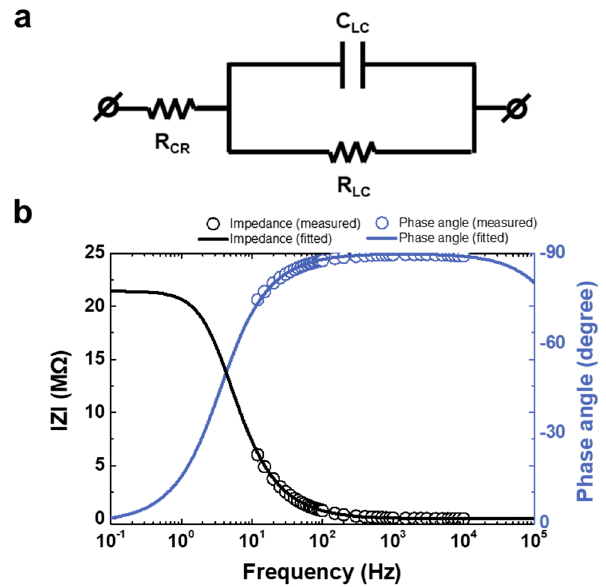
Figure 6. ( a ) Equivalent circuit model of a pure LC cell. ( b ) Measured magnitude | Z | and phase angle ϕ in the impedance spectrum of a pure LC cell. The open circles and solid lines represent the measured and fitted results, respectively.